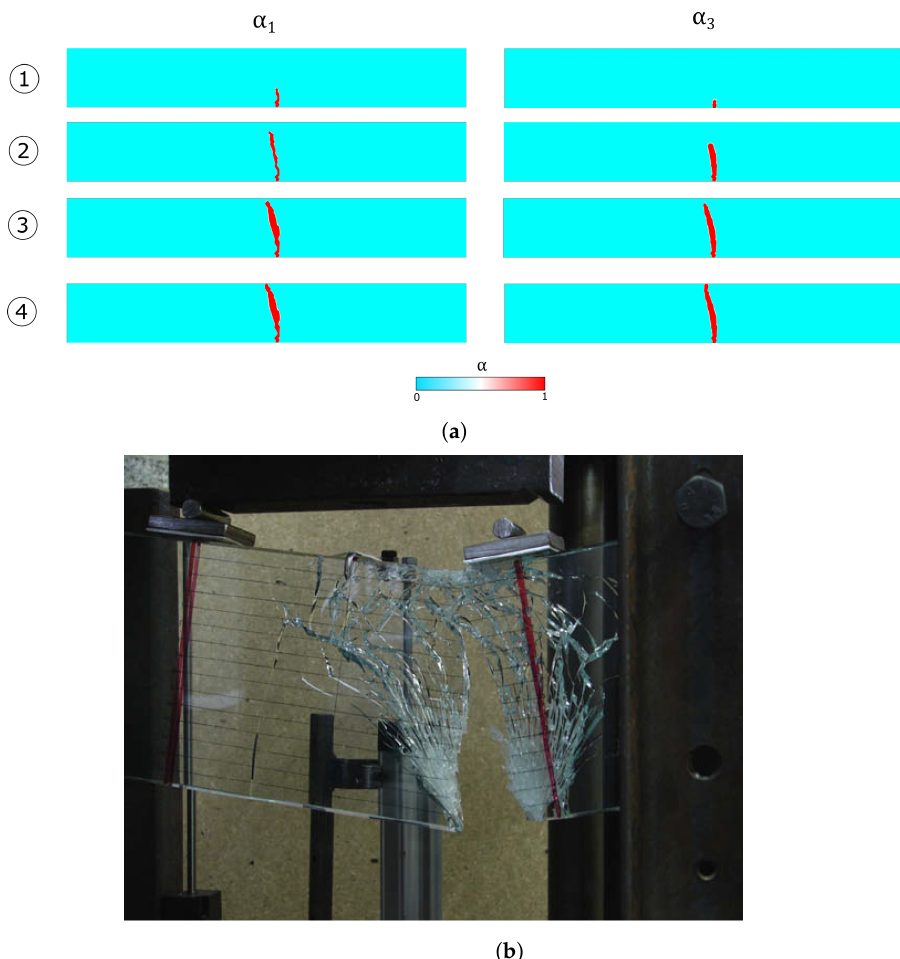
Figure 15. ( a ) Snapshots of the crack pattern at the instants reported in the circles. ( b ) Figure 10 from the work in [40], showing an example of fissured laminated glass